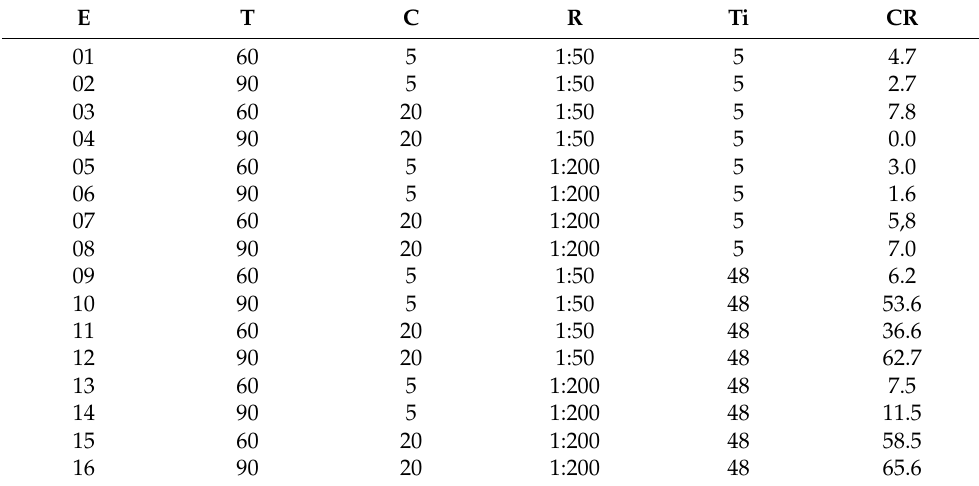
Table 7. Complete 2 4 factorial planning and measured output (conversion